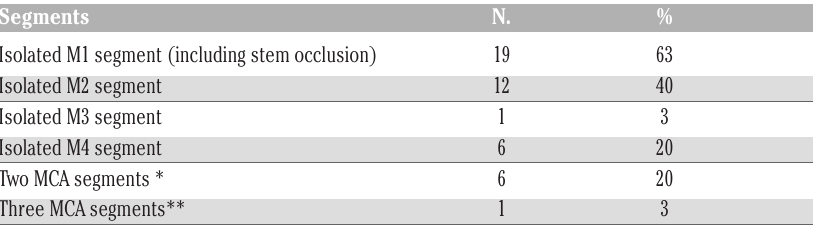
Table 1. Segments of middle cerebral artery thrombus on susceptibility-weighted images (30 patients). Segments